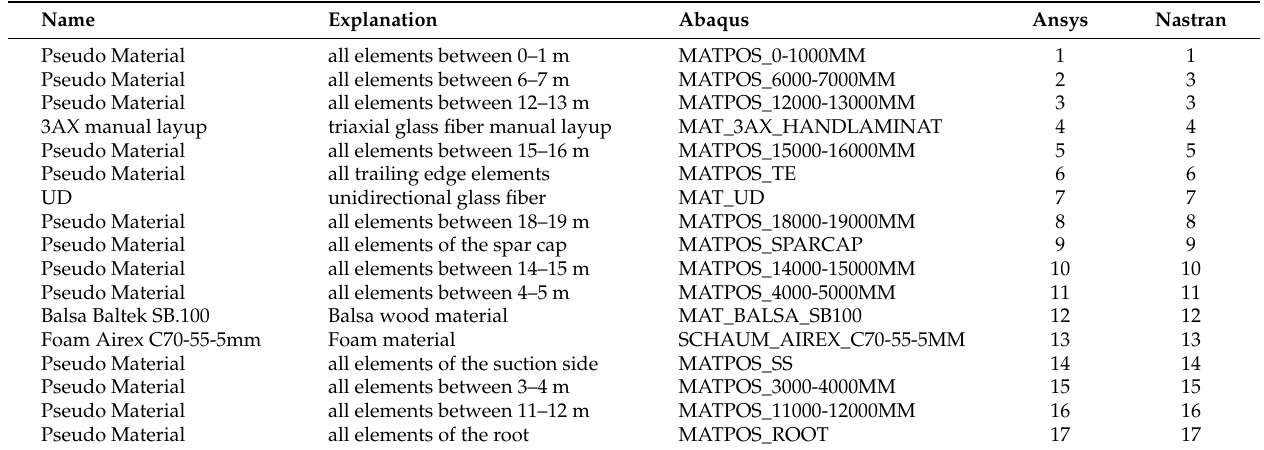
Table A3. List of materials given in Table